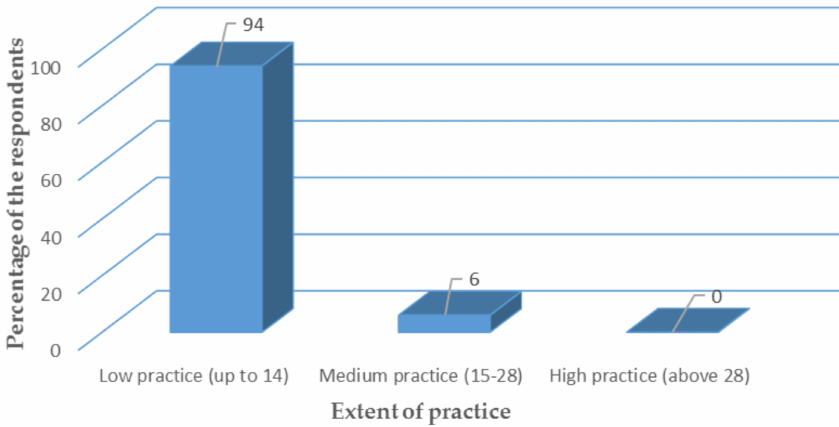
Figure 3. Extent of practice of the drought coping strategies by the